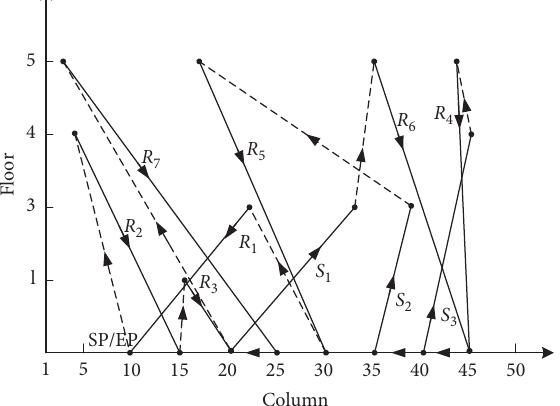
Figure 1: Layout of multi-I/O depots AS/RS.